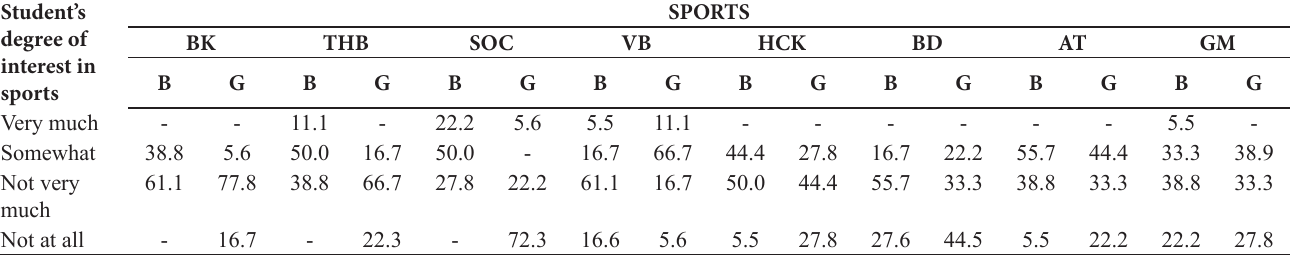
Table 3. Teachers’ opinions about boys’ (B) and girls’ (G) interest (in percentages) in the sports habitually played in their classes. BK = basketball,